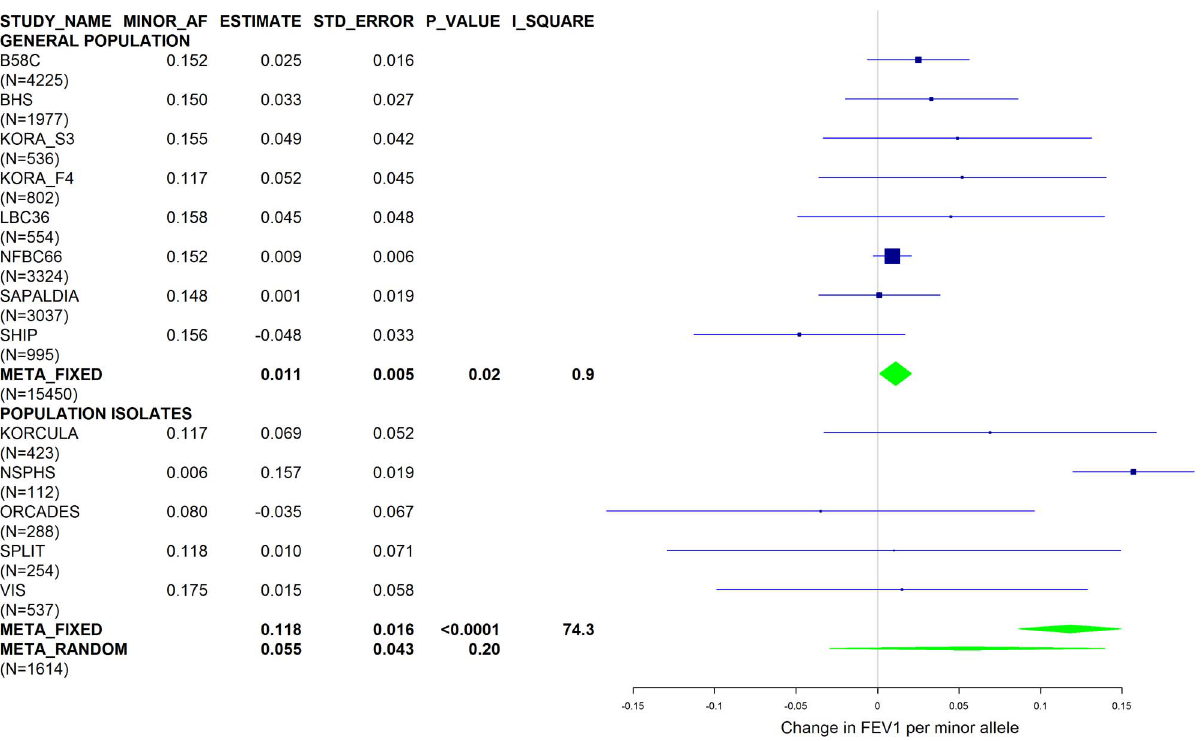
Figure 8. Forest plot of meta-analyzed results for the effect per minor allele of rs3748312 on FEV1 in ever-smokers, adjusted for sex, age, height, population stratification factors and the presence of PI S and Z alleles. Studies based on population isolates with a high degree of cryptic relatedness are presented separately. Effect estimates of meta-analyses are shown with green diamonds. I 2 is a measure of the heterogeneity between studies. Random effect meta-analyses are included if I 2 . 0.5. Study weights (blue squares) correspond to fixed effect meta- analyses. doi:10.1371/journal.pgen.1003585.g008 Split, SHIP, UBC, and Vis (imputation-r 2 0.86–0.98, 0.69–0.83,